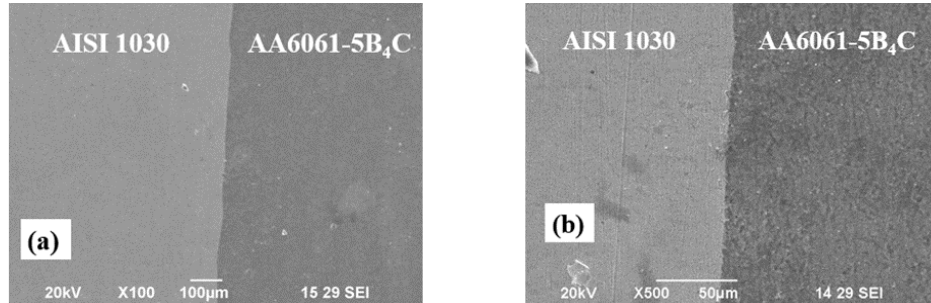
Figure 9. Scanning electron micrograph at the interface of the welded joint processed in an inert atmosphere, ( a ) at a magnification of 100× and ( b ) at a magnification of 500×.